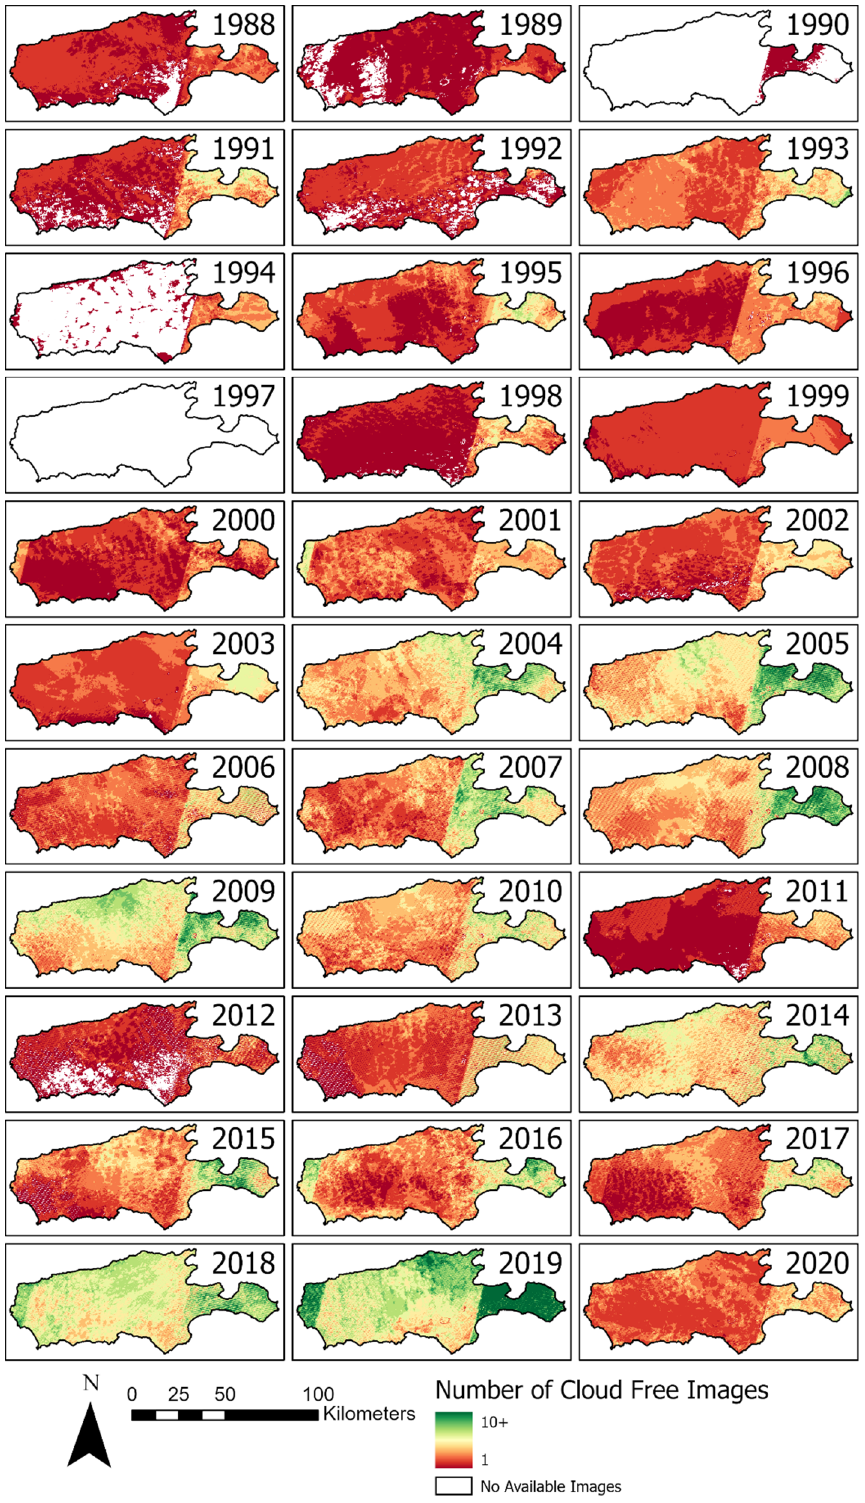
Figure 3. Number of cloud free images available for every pixel in each summer (December 25–March 25) across Kangaroo Island.